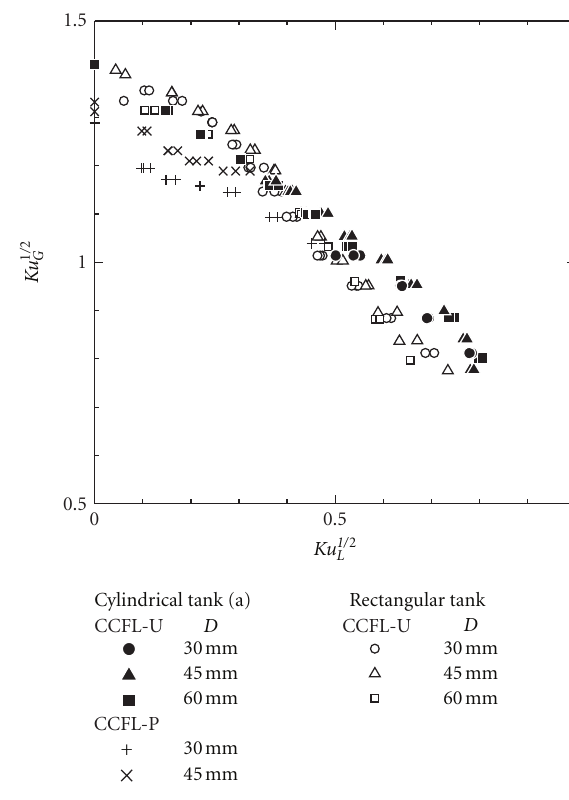
Figure 5: E ff ects of upper tank geometry on CCFL characteristics.